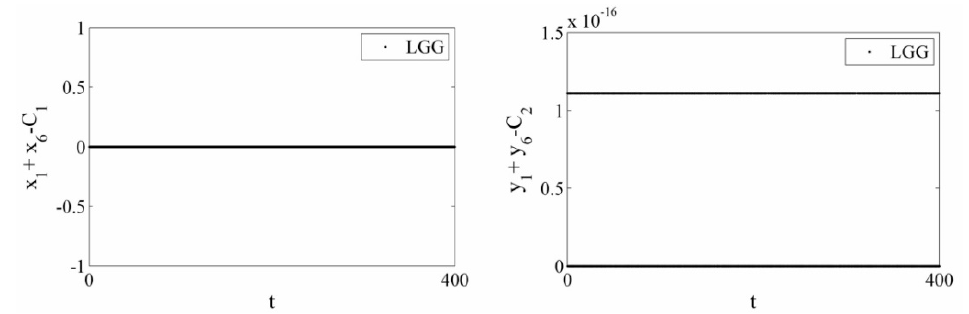
Figure 10. The trajectory of the six balls of the LGG algorithm during the time 300 400 s  with 2 m = and 0.1 η= .